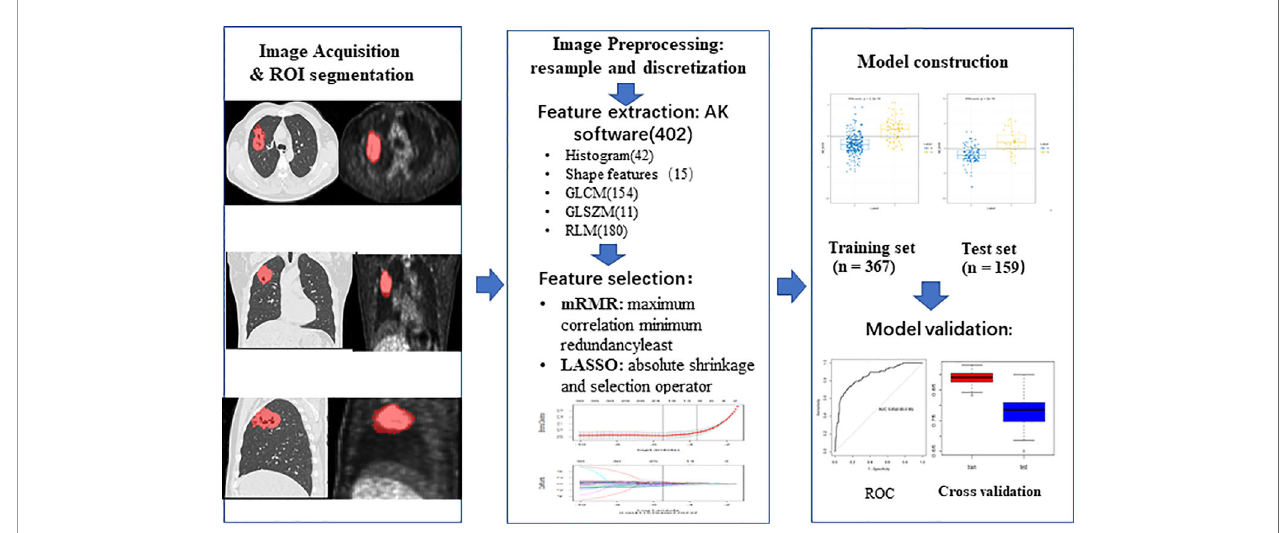
FIGURE 2 | The work fl ow of radiomic analysis. Feature extraction: AK software (402), 402 means the total number of extracted features from AK software. ROI, region of interest; GLCM, gray level co-occurrence matrix; GLSZM, grey level size zone matrix; RLM, run length matrix; mRMR, minimum redundancy and maximum correlation; LASSO, least absolute shrinkage and selection operator; ROC, receiver operating